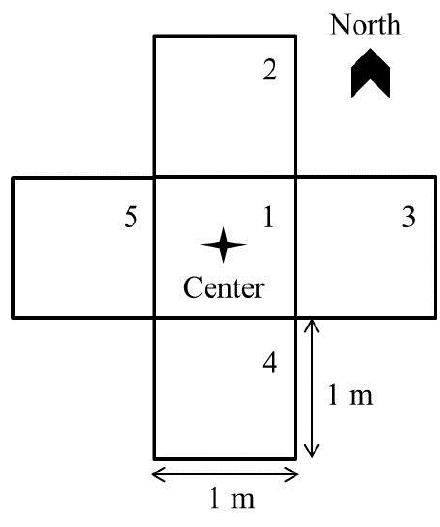
Figure 2. Sample plot pattern used for gathering the logging residues in the clear-felled area and under the harvester